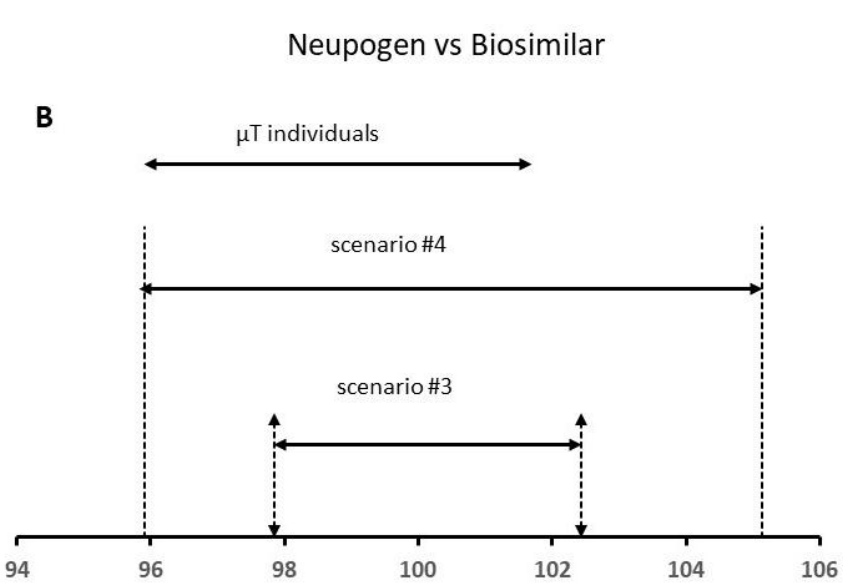
Figure5. ResultsoftheQRapproachfordifferentscenariosusing( A )Bevacizumaband( B )Neupogendata. Figure 5. Results of the QR approach for different scenarios using ( A ) Bevacizumab and ( B ) Neupogen The similarity is demonstrated when the µ T individual values are within the QR of the reference data. The similarity is demonstrated when the µT individual values are within the QR of the reference product.